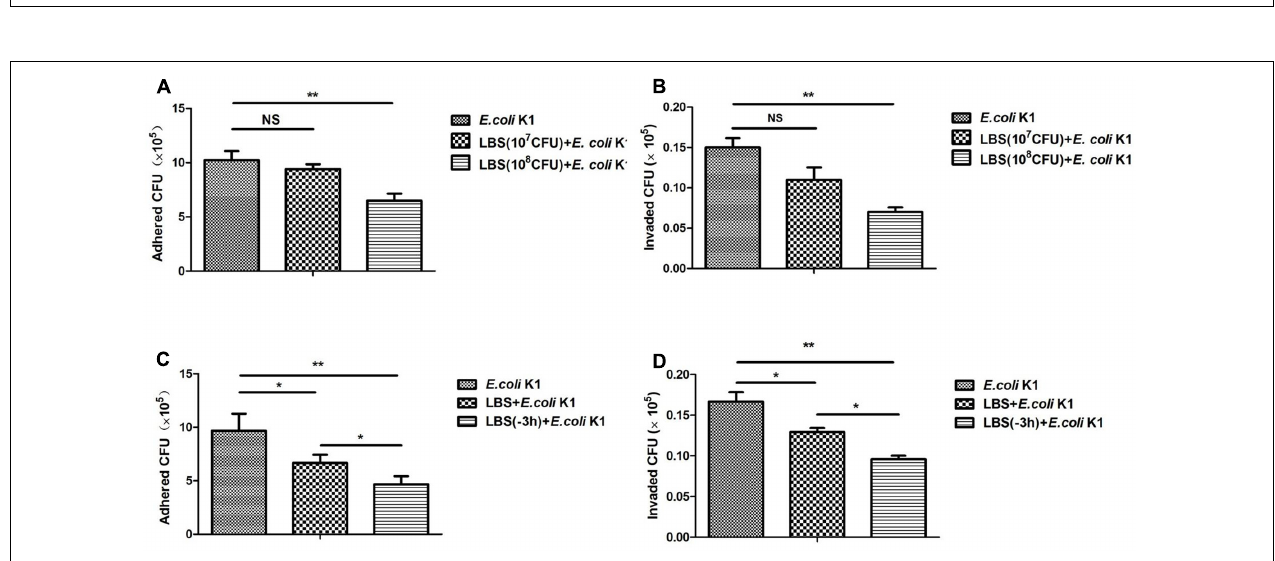
FIGURE 2 | Lactobacillus bulgaricus , Bifidobacterium, and Streptococcus thermophilus inhibits adhesion and invasion of E. coli K1 to HT-29 cells. HT-29 cells were cultured in 24-well plate and pre-treated with various doses of LBS for 3 h before adding E. coli K1 or co-incubated with LBS plus E. coli K1. Adhesion and invasion assays were carried out as described in section “Materials and Methods.” The numbers of associated bacteria (A,C) and intracellular bacteria (B,D) were determined. Results are represented as mean ± SD. ∗ P < 0.05, ∗∗ P < 0.01.